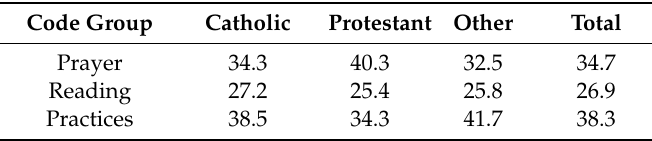
Table 3. Code groups and personal context—church a ffi liation. Code